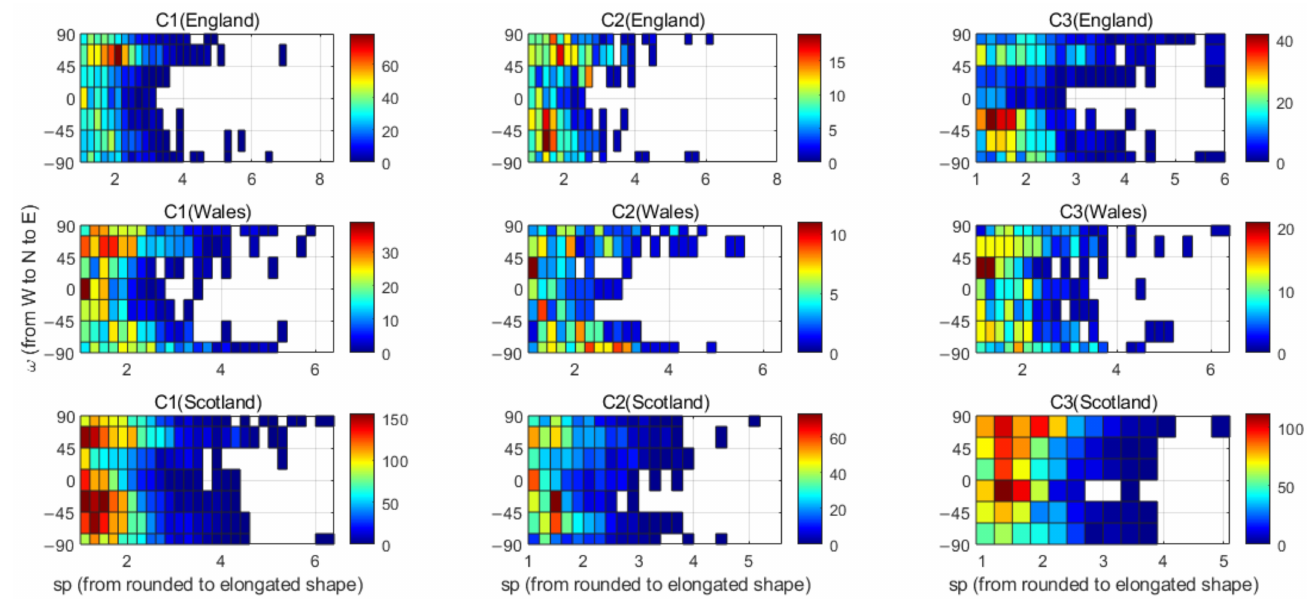
Figure 5. The histograms of the number of daily rainfall patterns in England, Wales and Scotland are displayed in different colours with respect to sp and ω in three sizes (C1, C2 and